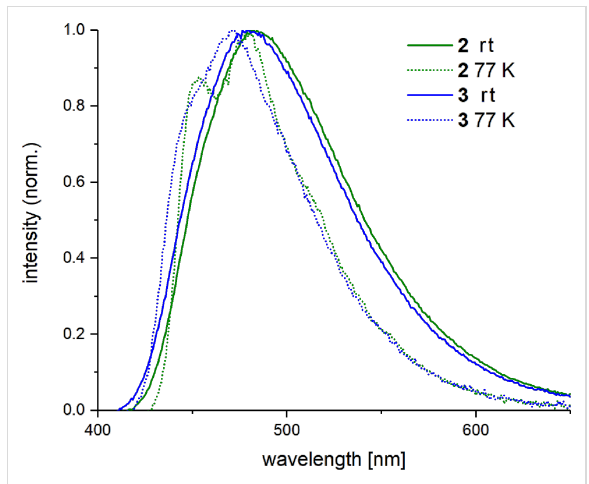
Figure 3: Emission spectra of complexes 2 and 3 measured at room temperature and 77 K, 2 wt % in a PMMA matrix and 0.5 mM in 2-MeTHF, respectively ( λ exc = 320 nm).